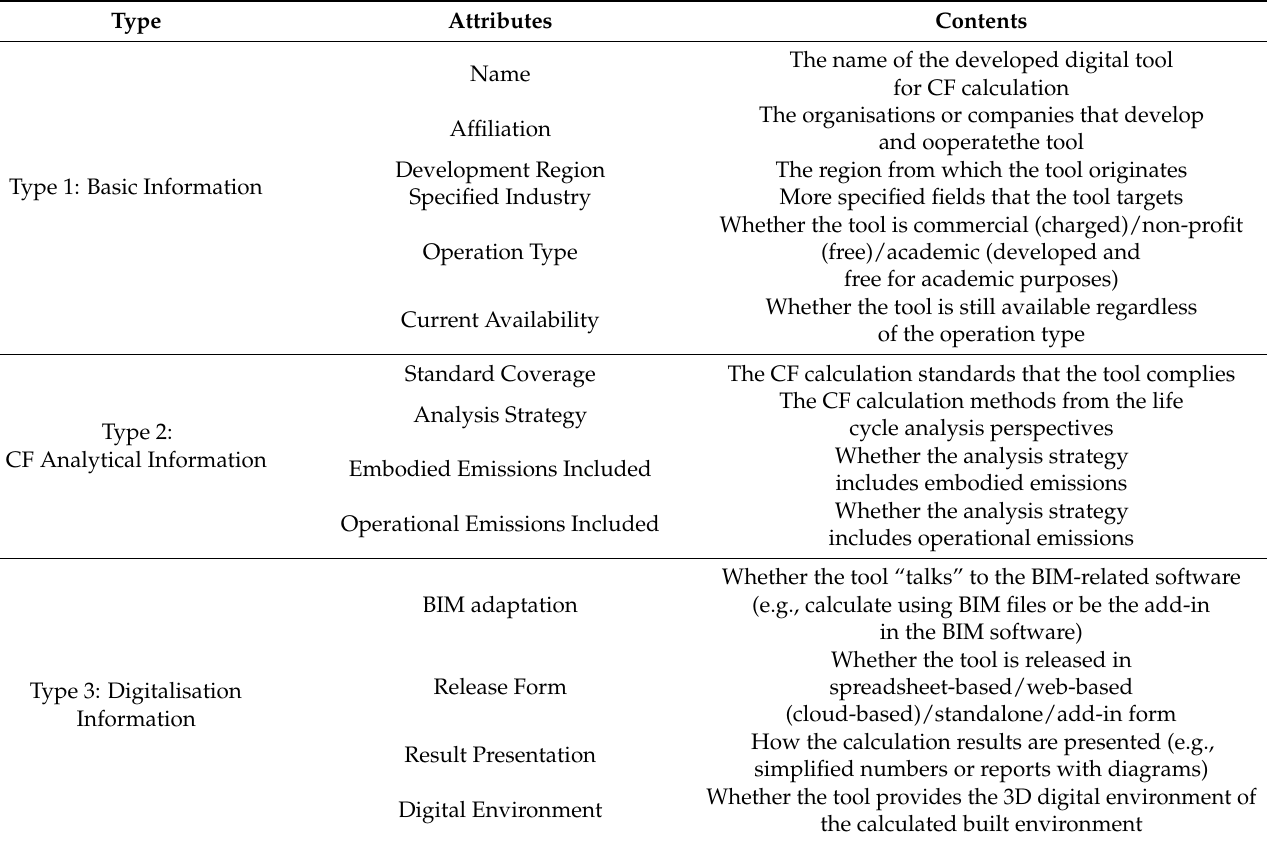
Table 1. Summary of the review